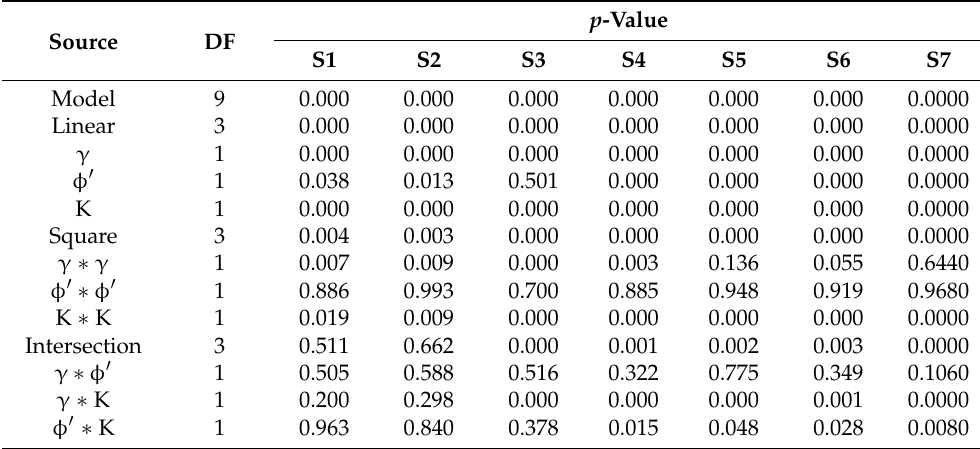
Table 4. ANOVA of the response-surface model.